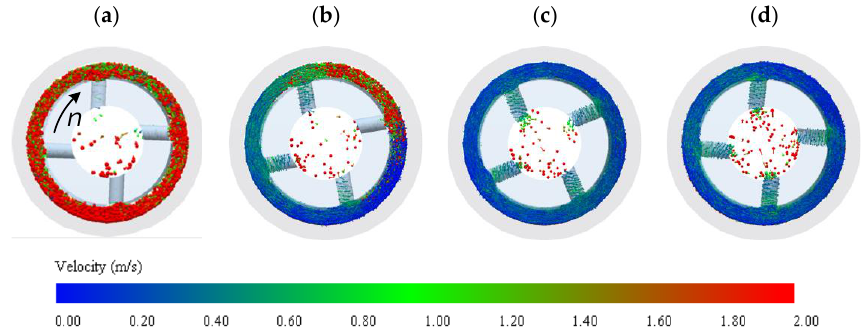
Figure 11. Drilling cutting velocities at: ( a ) 0.2 s, ( b ) 0.4 s, ( c ) 0.6 s, and ( d ) 0.8 s.